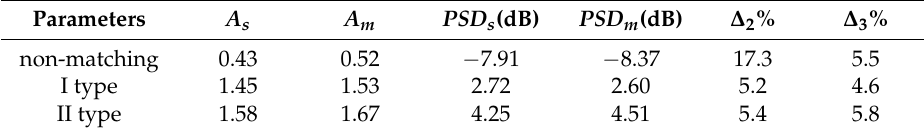
Table 7. The frequency and power spectrum analysis results for the pitch-catch